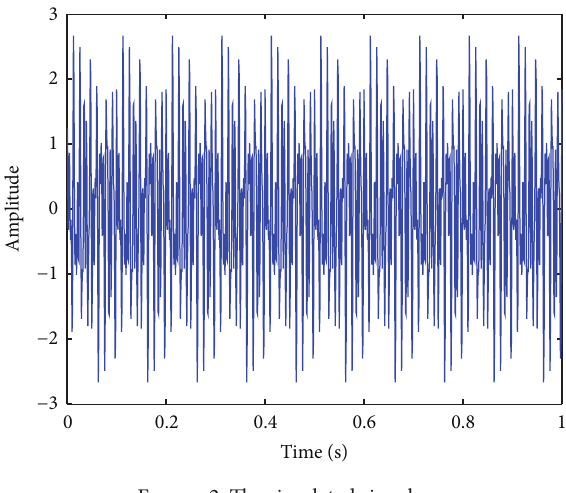
Figure 2: The simulated signal 𝑠 .